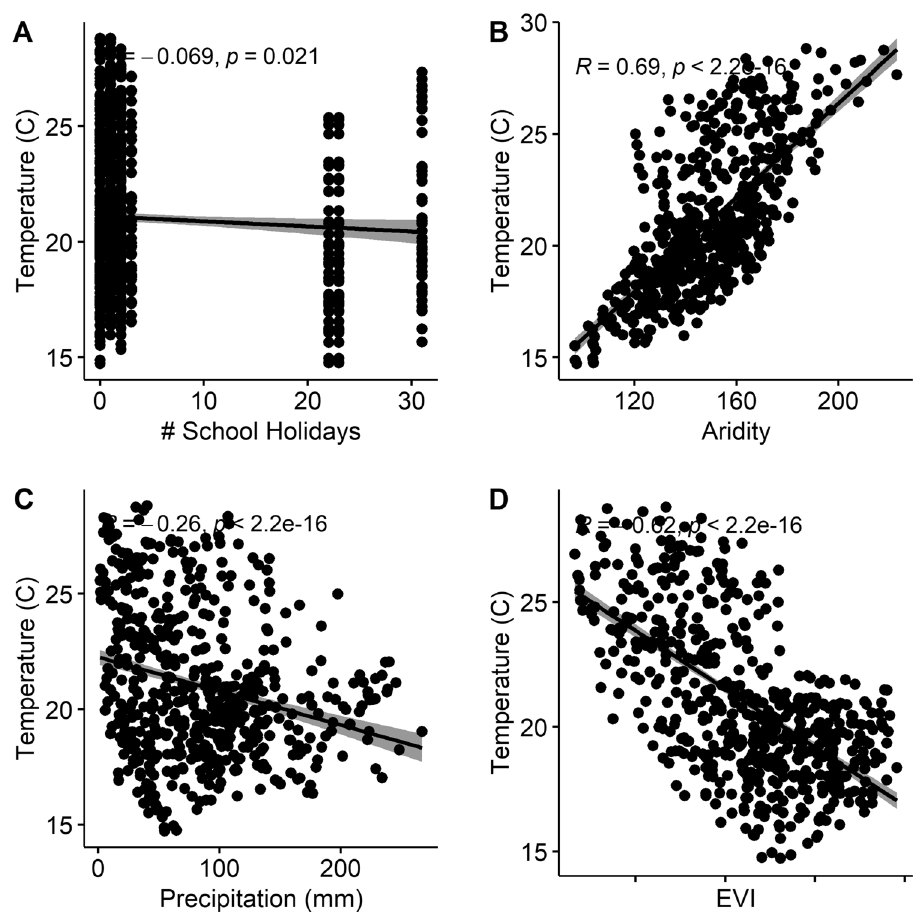
Figure 5. Correlation plots between ( a ) temperature (°C) and number of school holidays per month; ( b ) temperature (°C) and aridity; ( c ) temperature (°C) and precipitation (mm); and, ( d ) temperature (°C) and enhanced vegetation